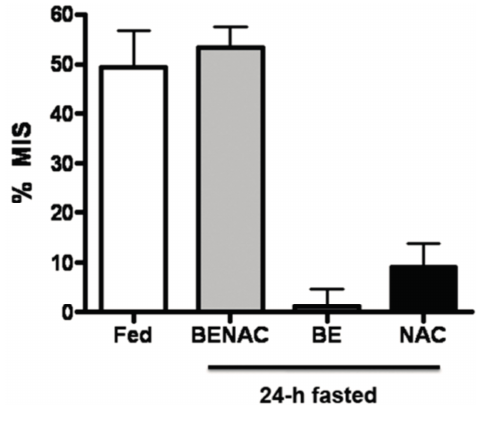
Figure 5. MIS induced by mimicking the two feeding signals administered in the fasted state. Mimicking the two feeding signals by drug administration in 24 hours fasted